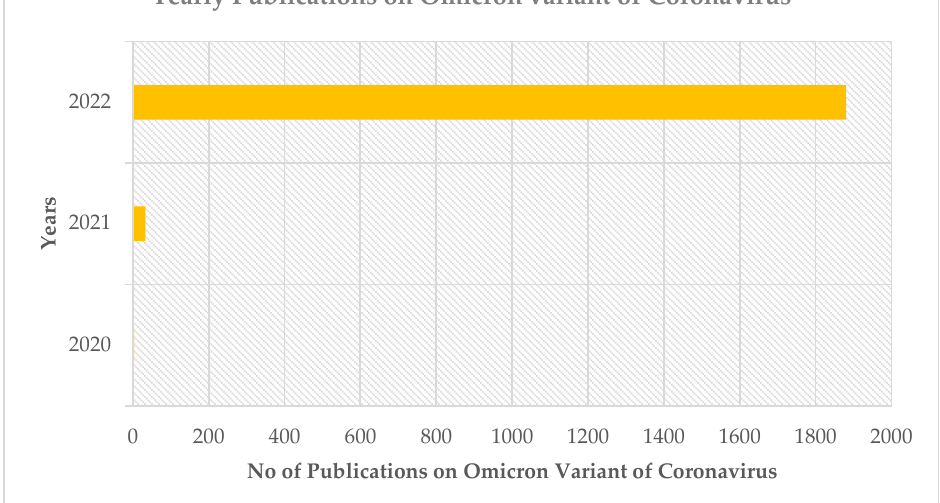
Figure 2. The annual publication growth trend of Omicron variant ‐ based research.